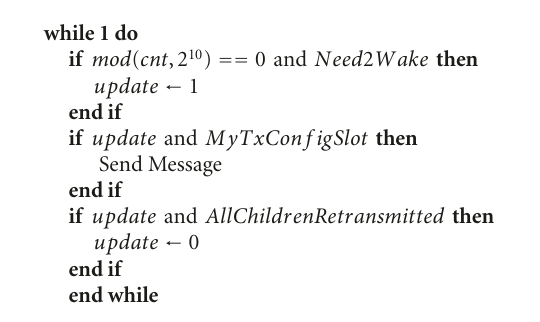
Algorithm 2: Active node’s procedure for new nodes activation.